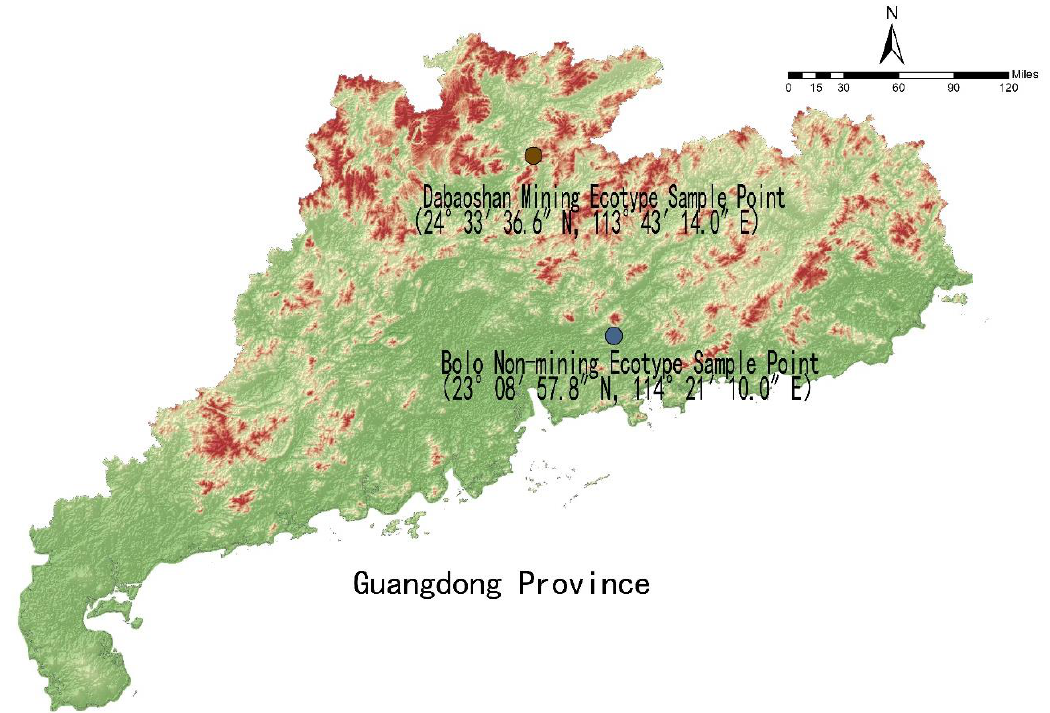
Figure 1. Location of sampling